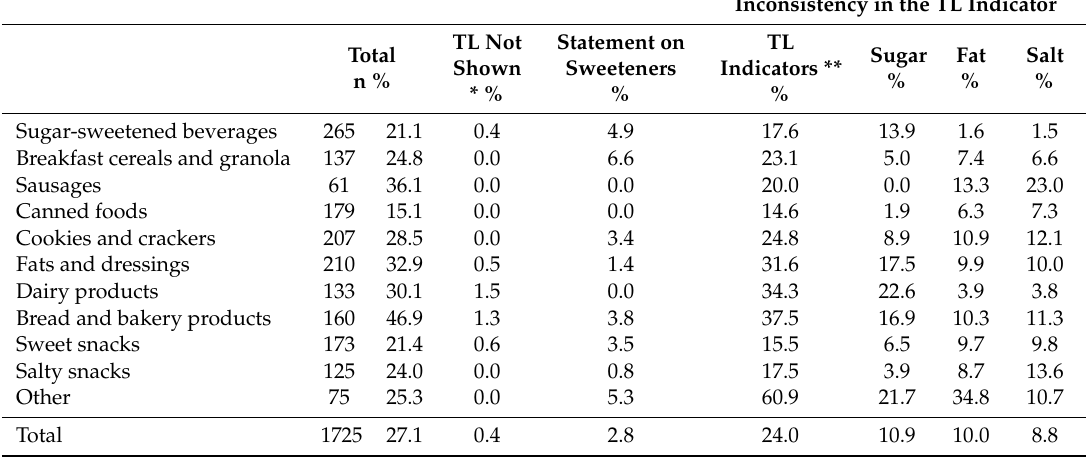
Table 4. Proportion of products with inconsistencies in the tra ffi c light label and statement on sweeteners by category of food.